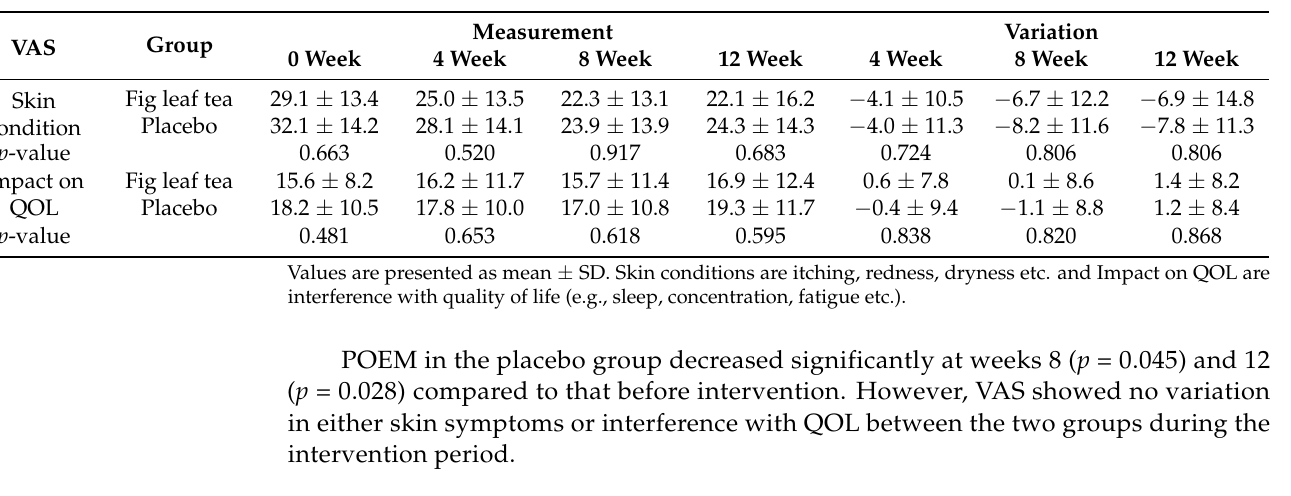
Table 5. Transition of VAS questionnaires.